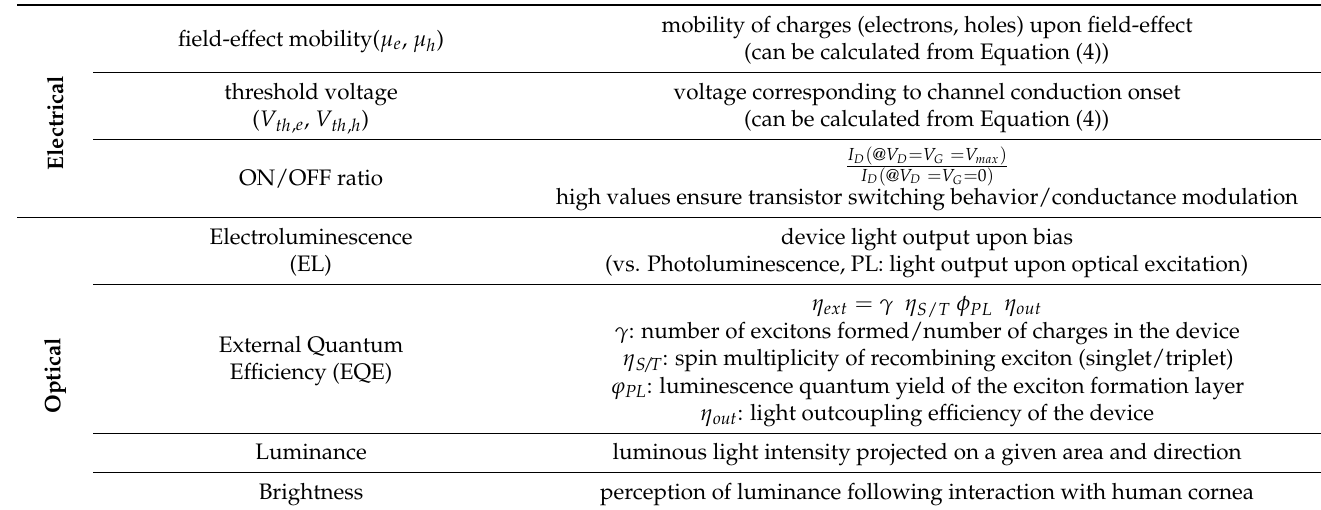
Table 2. Summary of the electrical and optical parameters of organic light emitting transistors.